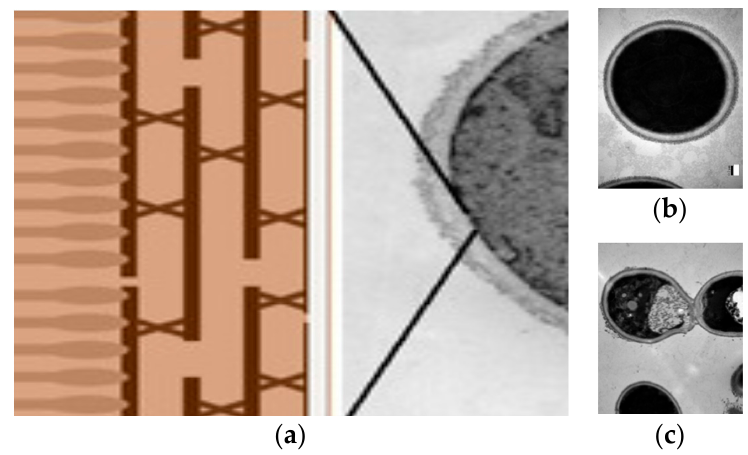
Figure 5. ( a ) Schematic molecular structure of yeast cell wall where the inner skeleton shows cross-linked polysaccharides and chitin parallel to the cell surface with an outer dense brush of glycoproteins [104]. ( b ) Transmission electron micrographs (TEM) of Candida albicans control. ( c ) TEM of Candida albicans damaged by a cationic antimicrobial polymer showing the burst of the cell membrane [106]. Adapted with permission from [106]. Copyright (2012) American Chemical Society.